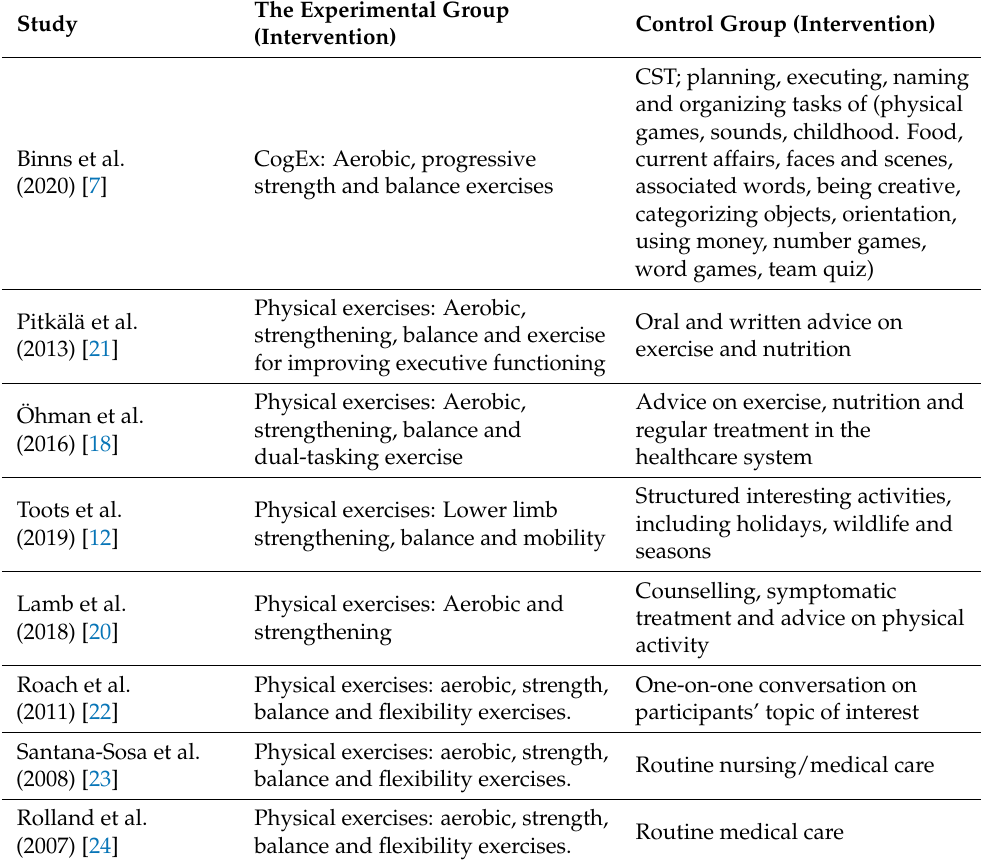
Table 4. Summary of intervention used in the experimental and control